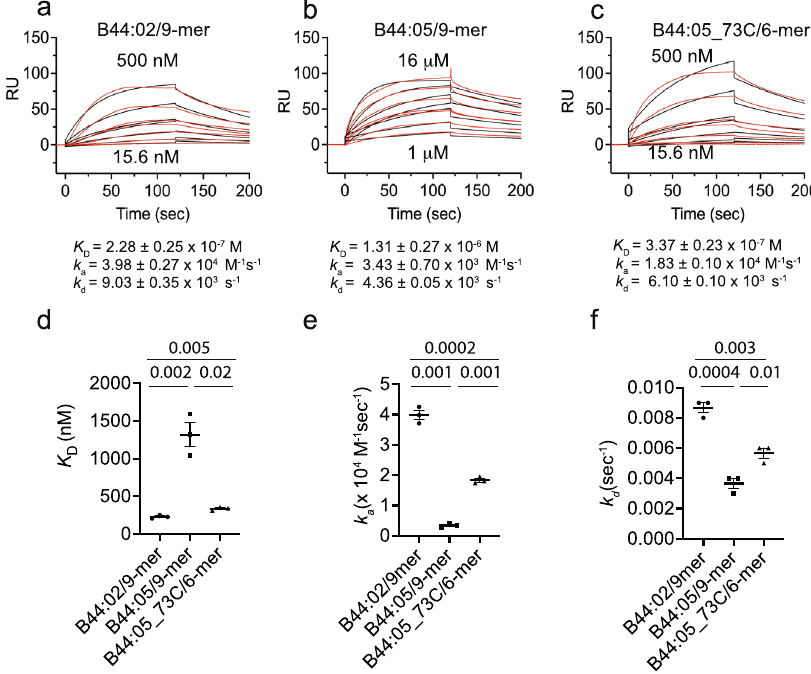
Fig.1|Af fi nityandkineticsoftheinteractionsbetweentapasinandB44:02and B44:05. a SPR analyses of the interaction of biotinylated tapasin captured on a streptavidin chip and B44:02 – 9mer. b B44:05 – 9mer. c B44:05-T73C – 6mer. Data are shown in red and fi ts of the data to a 1:1 binding model are overlaid in black. d equilibrium constant K D , e association rate constant k a and f dissociation rate constant k d . Kinetics data consisting of ( n =3) independent measurements of